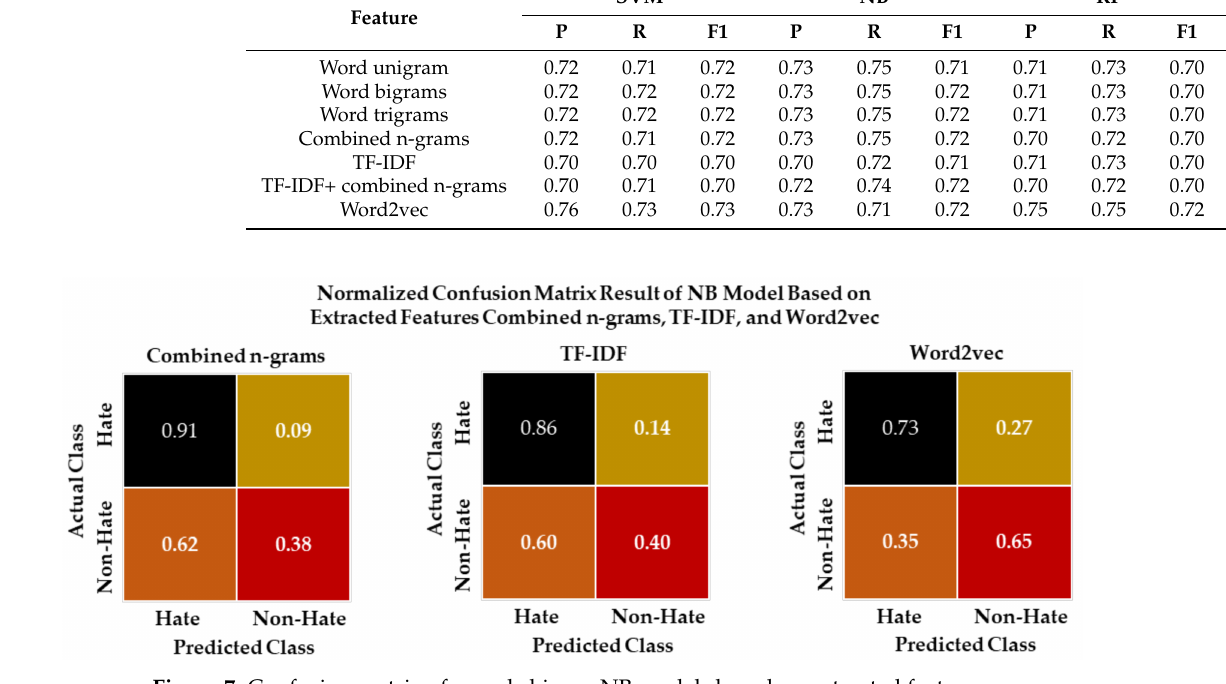
Figure 7. Confusion matrix of sample binary NB models based on extracted features.